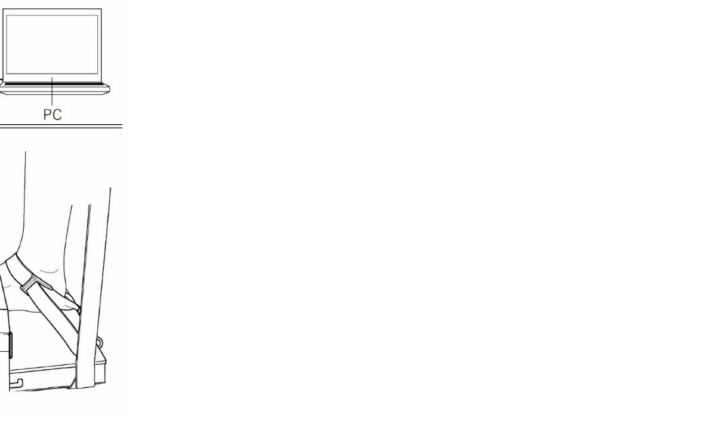
Figure 1. Structure of the metatarsophalangeal joint (MTPJ) plantar-flexion torque-mater for measur- ing the isometric torque.